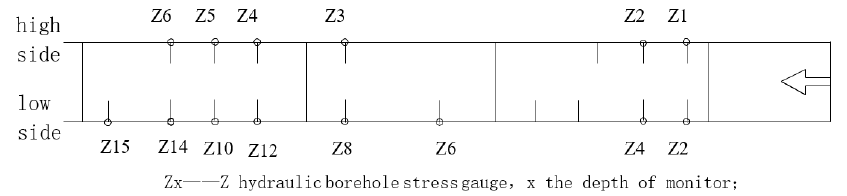
Figure 2. 11318 Graphic layout of measuring station.